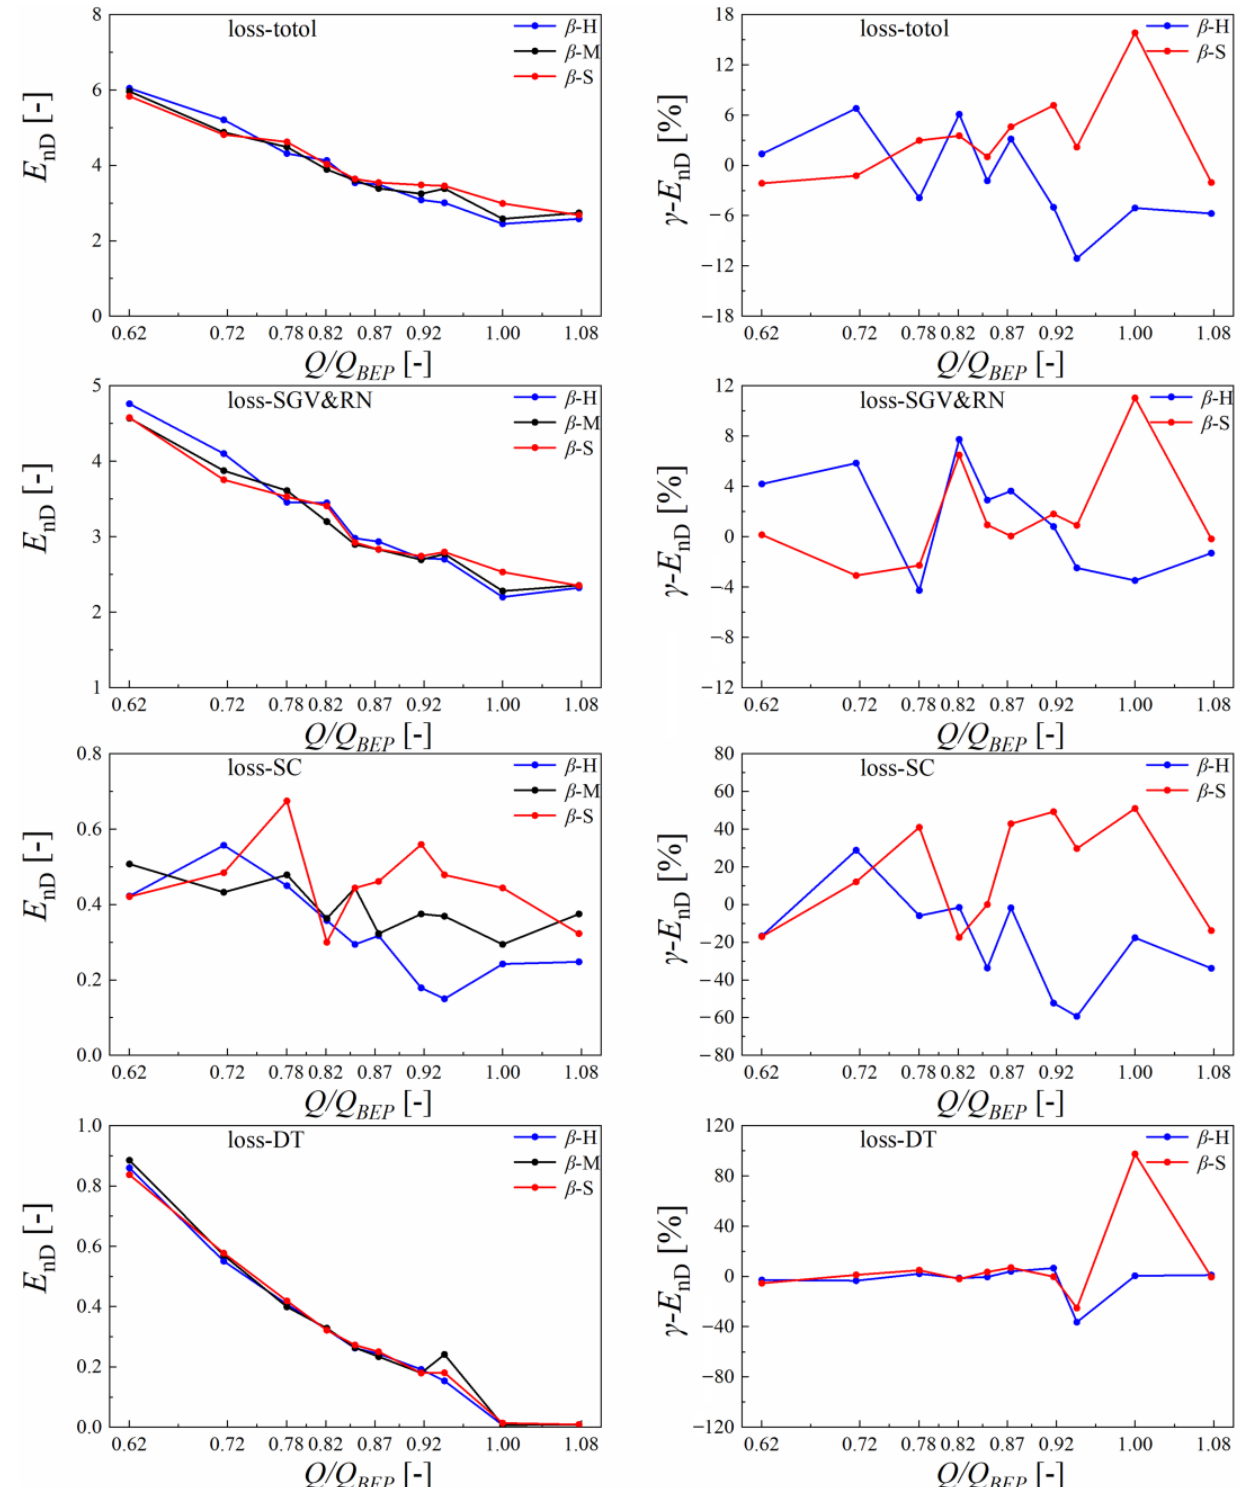
Figure 14. Distribution and relative change rate of hydraulic loss.